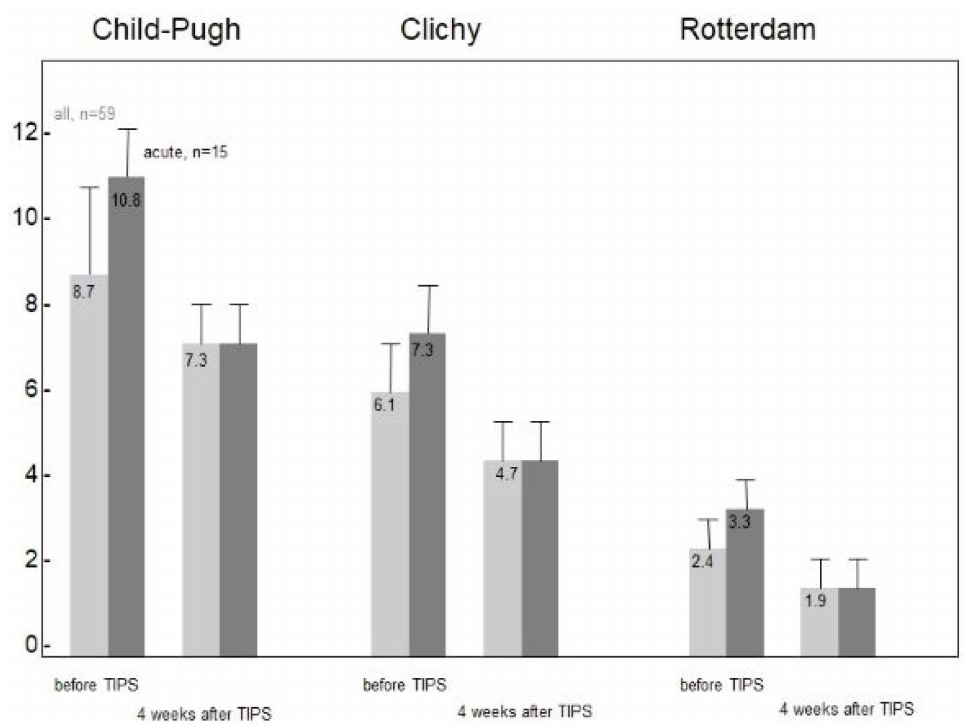
Figure 8. Development of Child–Pugh score, as well as Clichy and Rotterdam prognostic BCS indexes in 59 patients. TIPS improves the Child–Pugh score as well as the Clichy and the Rotter- dam indexes significantly during the index hospital stay and thereafter. The effect was greatest in patients treated for acute or fulminant BCS (Adapted and modified with permission from Dr.